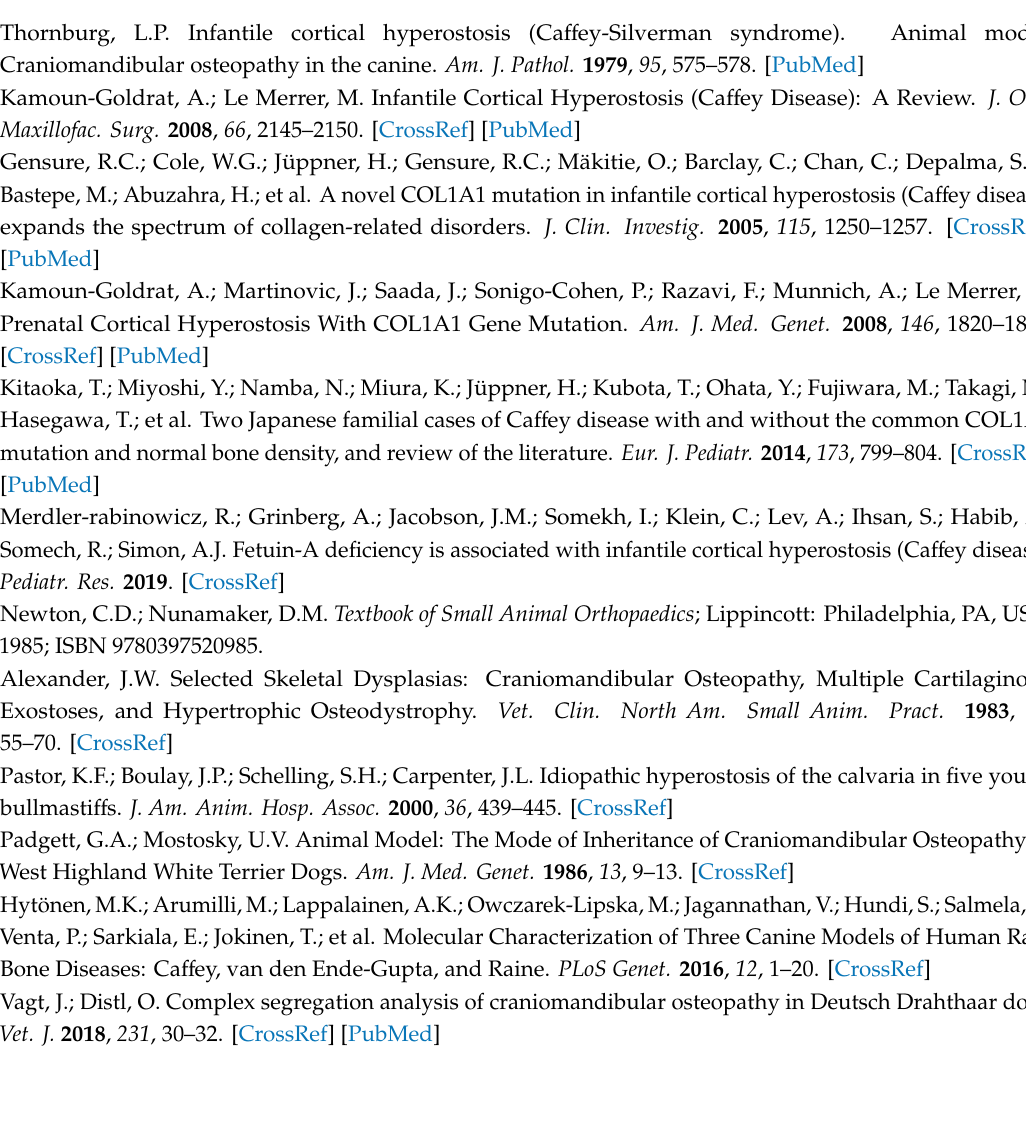
Table S1: Detailed information of all whole-genome sequences. Table S2: List of private variants of the sequenced CMO-a ff ected Australian Terrier. Table S3. List of private variants of the sequenced CHS-a ff ected American Sta ff ordshire Terrier. Table S4. List of private variants of the sequenced CMO-a ff ected Basset Hound. Table S5. List of private variants of the sequenced CMO-a ff ected Cairn Terrier. Table S6. List of private variants of the sequenced CMO-a ff ected Curly Coated Retriever. Table S7. List of private variants of the sequenced CMO-a ff ected German Wirehaired Pointer. Table S8. List of private variants of the sequenced CMO-a ff ected Old English Sheepdog. Table S9. List of private variants of the sequenced CMO-a ff ected